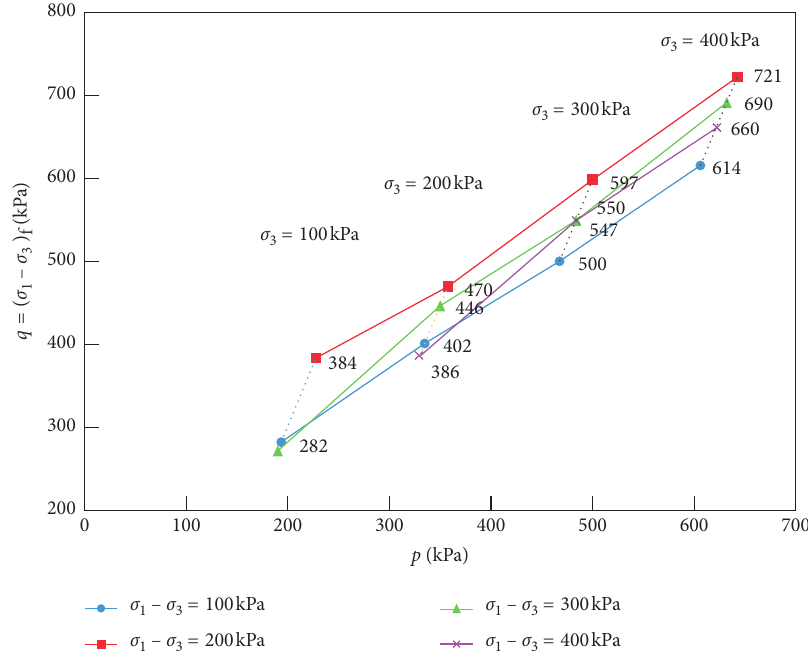
Figure 7: Peak shear strength versus mean